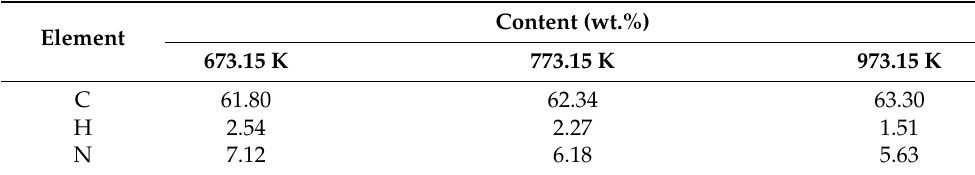
Table 2. Carbon, hydrogen, and nitrogen elemental analysis results of biochar as a function of pyrolysis